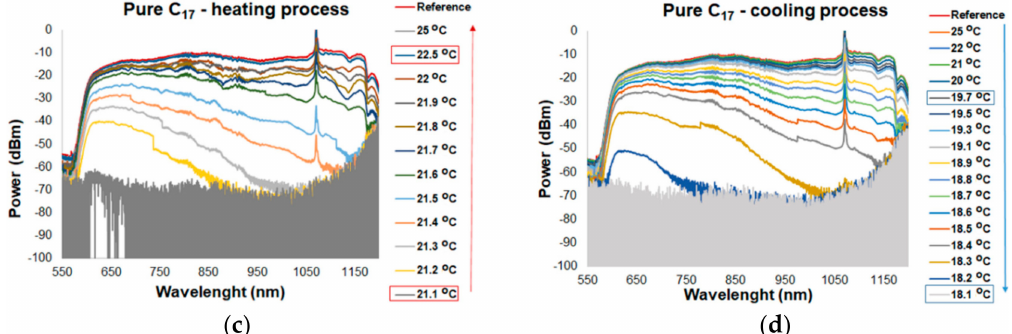
Figure 5. Transmission of a tapered optical fiber in the range of 550–1200 nm for di ff erent temperatures for: ( a ) heating process for pure C 16 , ( b ) cooling process for pure C 16 , ( c ) heating process for pure C 17 , and ( d ) cooling process for pure C 17 .